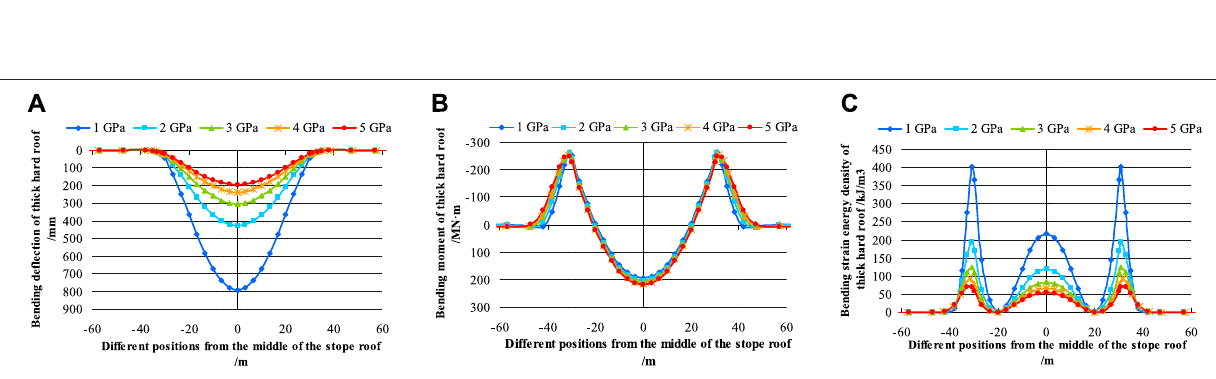
FIGURE 6 | Mechanical characteristics of the in fl uence of the rock stratum thickness on the mining bearing capacity of the thick hard roof. (A) Distribution characteristics of bending de fl ection. (B) Distribution characteristics of stressed bending moment. (C) Distribution characteristics of elastic energy accumulation.